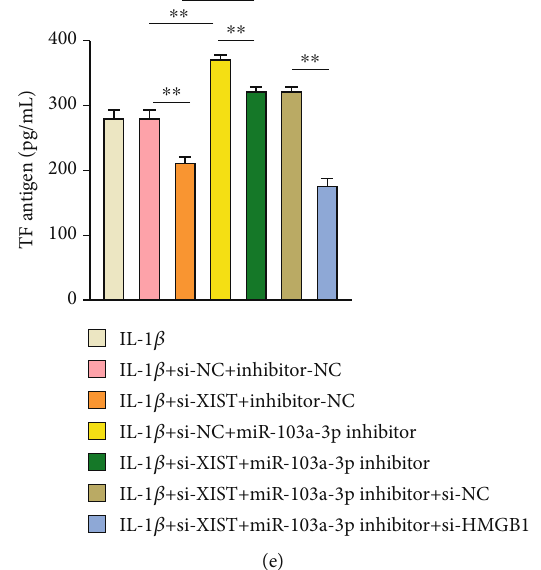
Figure 4: ROS-induced apoptosis and change of TF level based on adding IL-1 β were regulated via lncRNA XIST/miR-103a-3p/HMGB1. (a) The ROS production in cotransfected cells was analyzed by DCFH-DA staining. (b) The expression levels of proteins related to the NF- κ B pathway and apoptosis in cotransfected cells were analyzed by western blot. (c) The viability of cotransfected cells was determined by MTT assay. (d) The apoptosis of cotransfected cells was tested by Annexin V-FITC/PI double staining kit. (e) The concentration of TF antigen in cotransfected cells was determined by the ELISA kit. ∗ P < 0 : 05 and ∗∗ P < 0 : 01